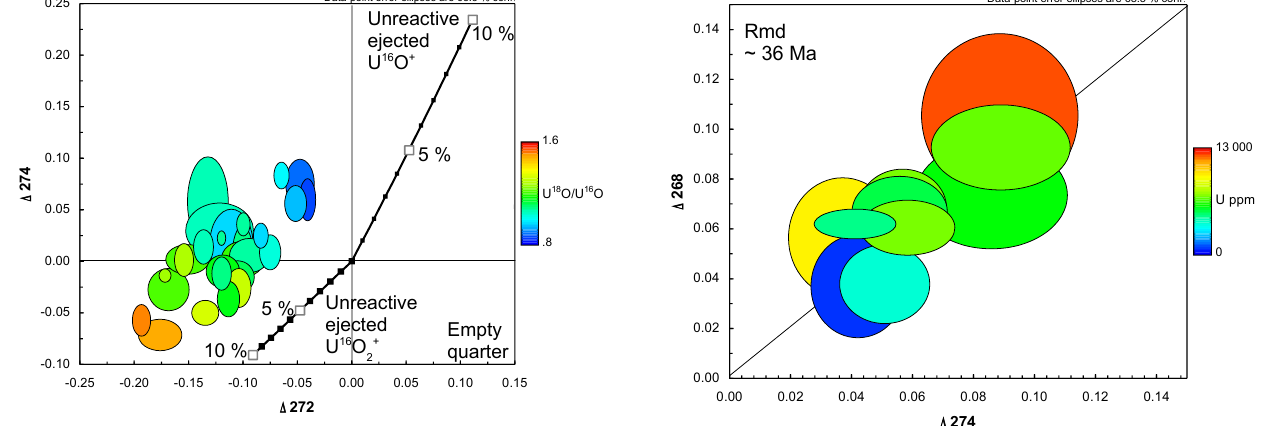
Figure 10. (cid:49) 274 vs. (cid:49) 268 plot for Raumid zircon. This plot shows that the dioxide disequilibrium is the same for Th and U oxides, so that the metal phase is unlikely to have much of a role in isotopo- logue